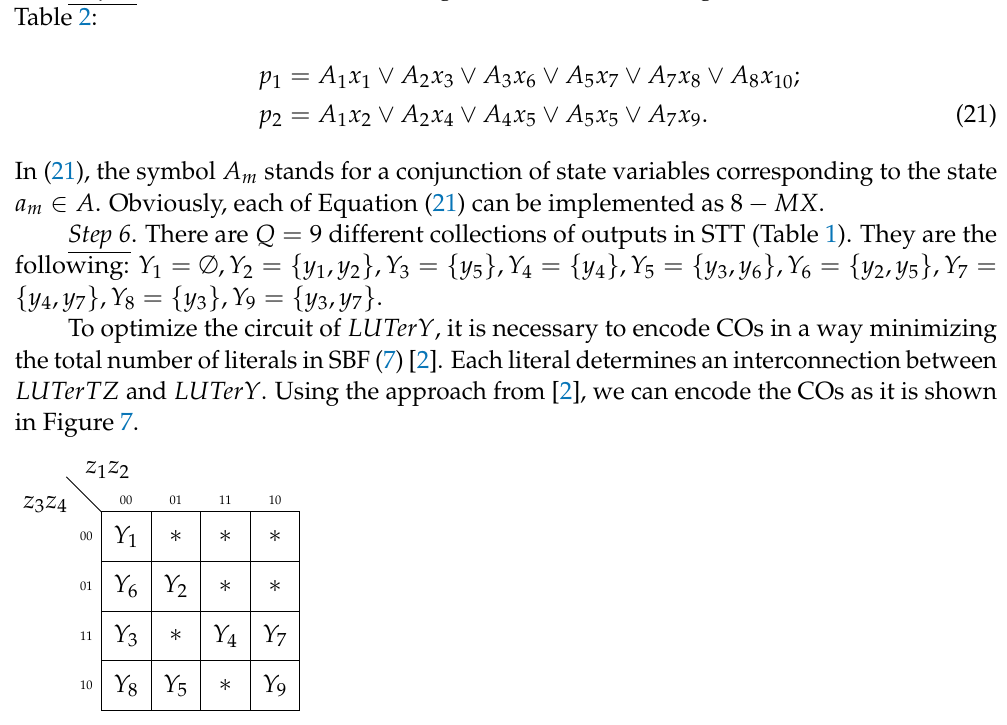
Figure 7. Outcome of encoding of COs for Mealy FSM MP C Y ( S 0 )